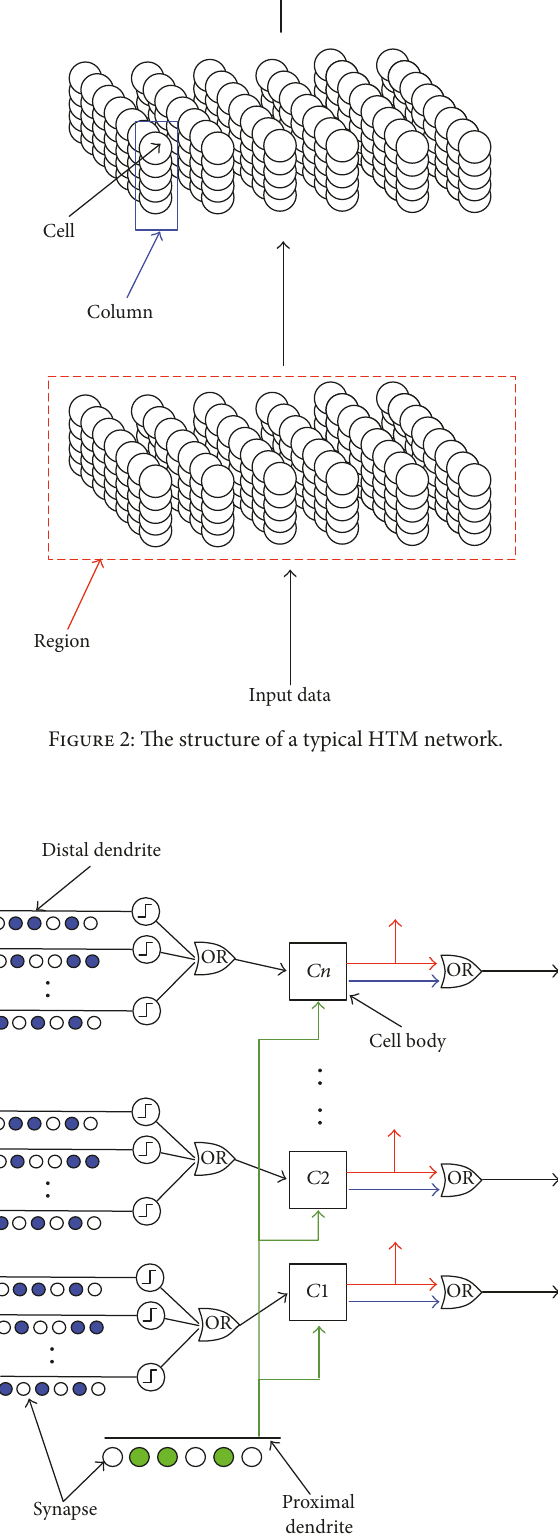
Figure 3: The structure of an HTM